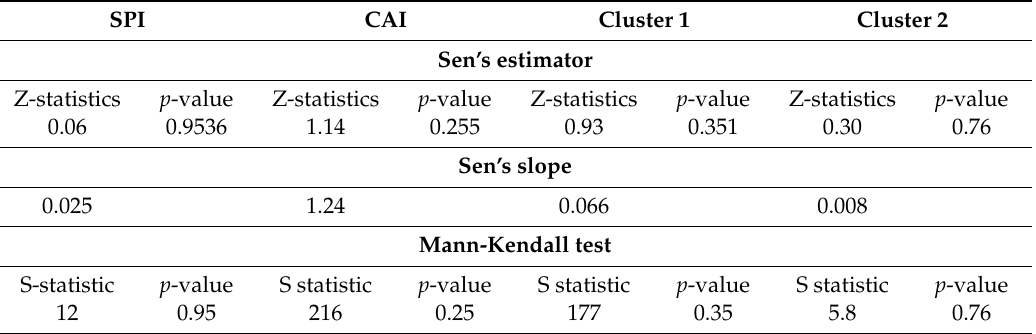
Table 4. Statistics and probability values of the Sen’s and Mann-Kendall test for temporal trends.